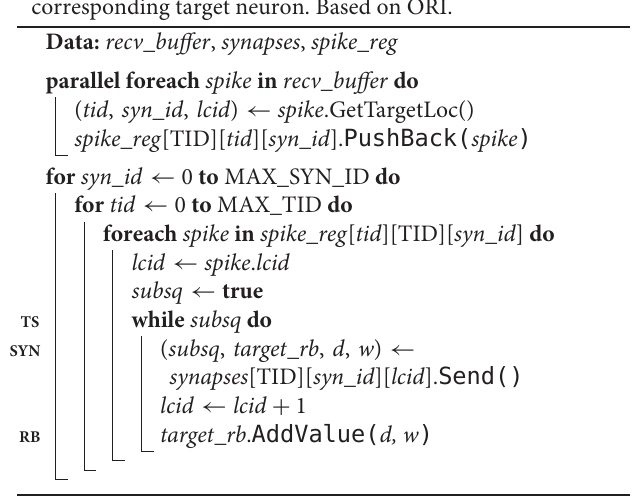
FIGURE 4 | Cumulative relative change in simulation time after a redesign of spike delivery as a function of the number of MPI processes M . Top left panel DEEP-EST CM and top right panel JURECA CM: linear-log representation for a number of MPI processes M ∈ { 2 ; 4 ; 8 ; 16 ; 32 ; 64 ; 90 } and M ∈ { 2 ; 4 ; 8 ; 16 ; 32 ; 64 ; 128 ; 256 ; 512 ; 1024 } , respectively. Weak scaling of benchmark network model with the same configuration as in Figure 3 ; error bars show SD based on 3 repetitions. Bottom panel K computer: number of MPI processes M ∈ { 32 ; 64 ; 128 ; 256 ; 512 ; 1024 ; 2048 ; 4096 ; 8192 ; 16,384 ; 32,768 ; 82,944 } , gray dotted curve: M ∈ { 32 ; 2048 ; 32,768 } . Weak scaling with different configurations (1 MPI process per compute node; 8 threads per MPI process; 18,000 neurons per MPI process). The black dotted line at zero indicates the performance of the original code (ORI, Section 2.3). The light carmine red curve indicates a change in sim time (shading fills area to reference) due to sorting of spike entries prior to delivery (SRR, Section 4.1). The dark carmine red curve indicates an additional change in sim time due to providing synapses with direct pointers to neuronal spike ring buffers (P2RB, Section 4.2). The dashed brown curve shows an additional change in sim time after removal of an unrequired generic function call (noSSG). Gray dotted curve indicates a hypothetical limit to the decrease in sim time assuming spike delivery takes no